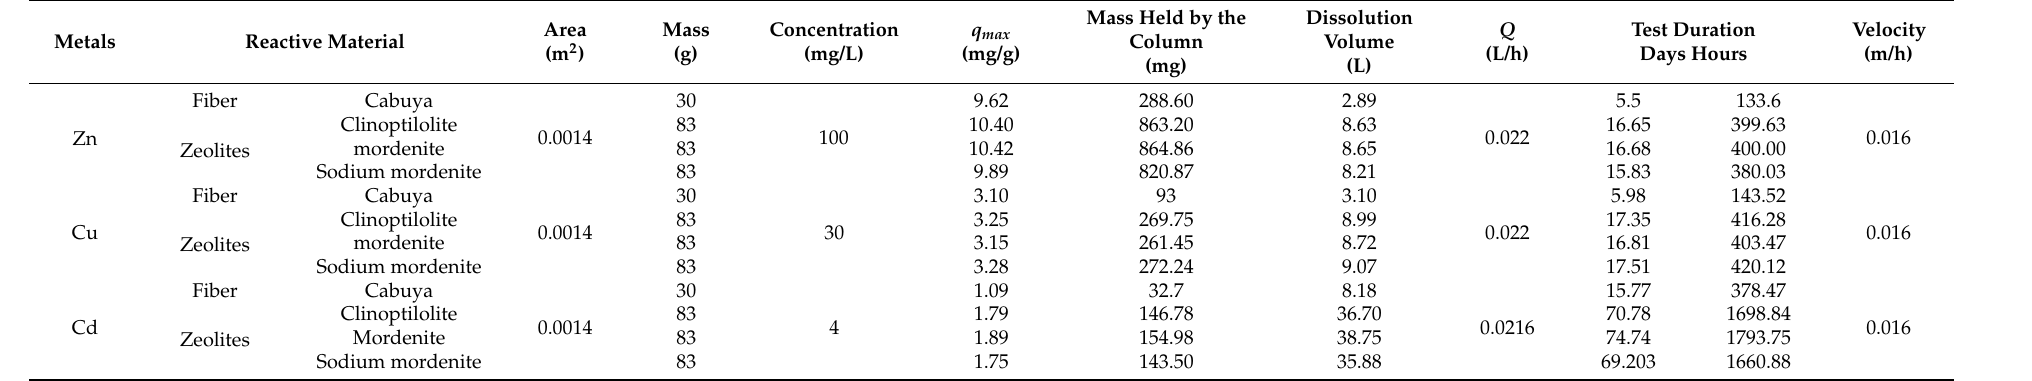
Table 5. Main parameters for sorption column tests for Zn(II), Cu(II) and Cd(II)